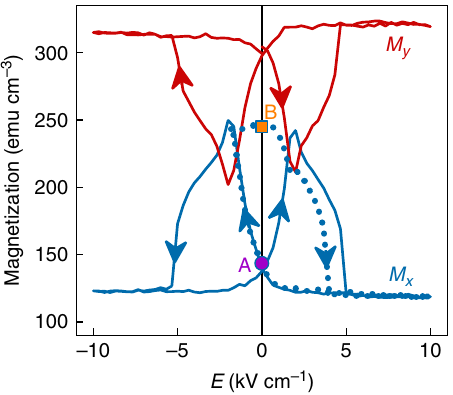
Fig. 3 Strain-mediated electrical control of macroscopic magnetization in LSMO:PMN-PT. In-plane magnetization components M x (blue) and M y (red) versus electric fi eld E . Remanent states A (purple dot) and B (orange square) were achieved via the minor loop shown for M x (dotted blue line). Data were obtained after applying and removing 1 kOe along the measurement direction, using sample A once it had undergone 30 bipolar electrical cycles (Supplementary Note 9). Similar major loops of M x ( E ) were obtained for samples B and C (Supplementary Note 10). All data were obtained at room temperature. Source data are provided as a Source Data fi le.